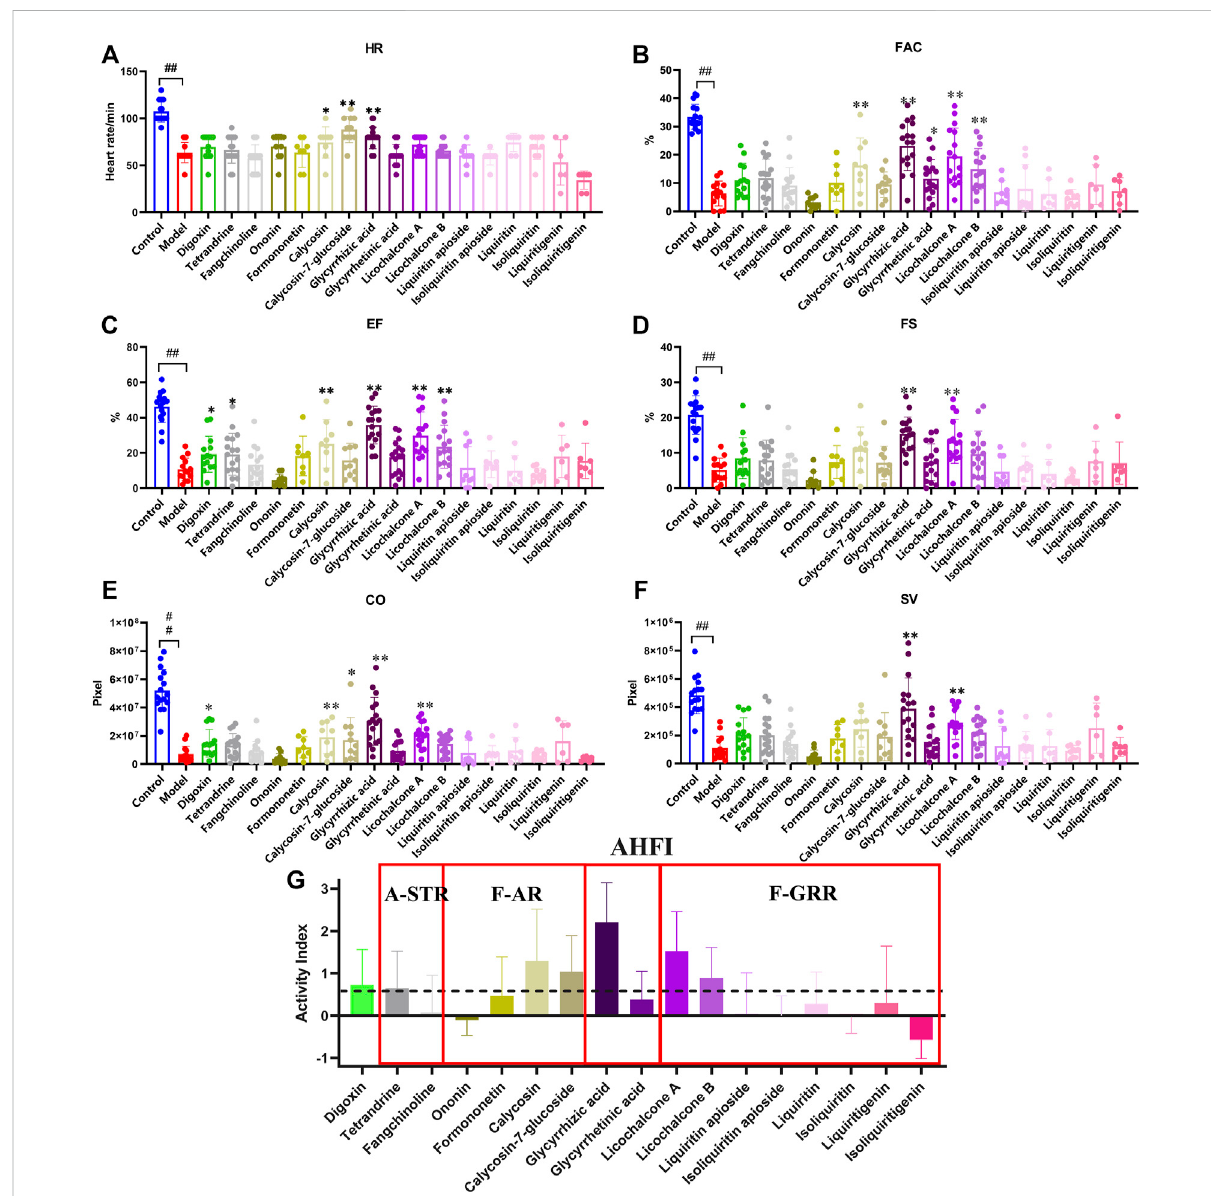
FIGURE 6 Thetherapeuticeffectsofmainingredientsinactivecomponentsonverapamil-inducedheartfailuremodelinzebra fi sh (A – F) Quanti fi cationof cardiac function in Tg(cmlc2: eGFP) zebra fi sh larvae treated with ingredients. (G) Quanti fi cation indicators of AHFI, the dotted line indicates an AHFI value of 0.6. N ≥ 6. # p < 0.05 vs . Control, ## p < 0.01 vs . Control, * p < 0.05 vs . Model, ** p < 0.01 vs .